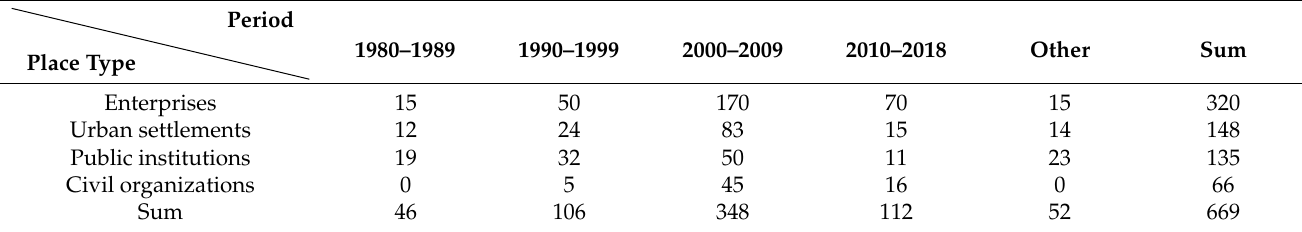
Table 7. Place types in the south of Sanya: the top four types of changes in the total number of place names in Sanya in different periods.